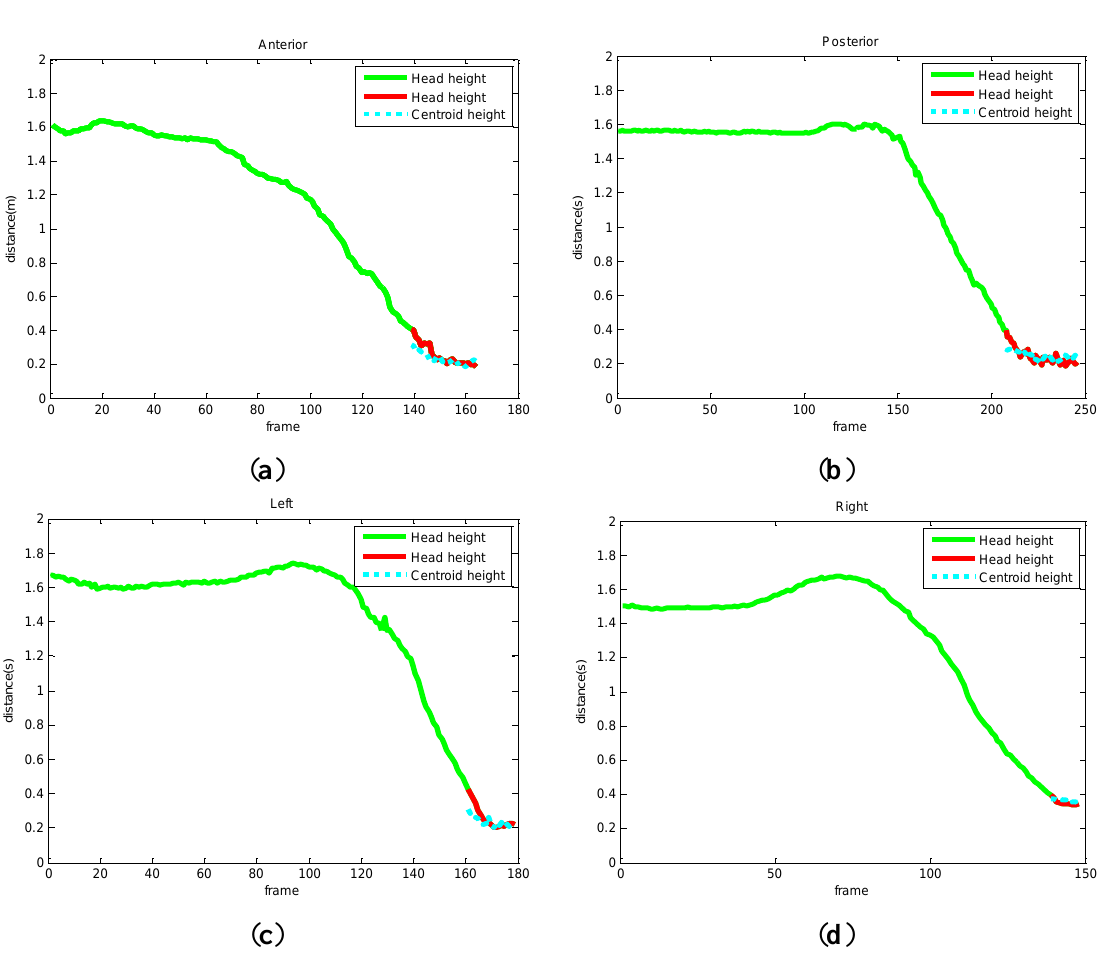
Figure 8. Trajectories of the distance from the head and centroid to the floor in different orientations. ( a ) Falling down from the anterior orientation; ( b ) falling down from the posterior orientation; ( c ) falling down from the left orientation; ( d ) falling down from the right